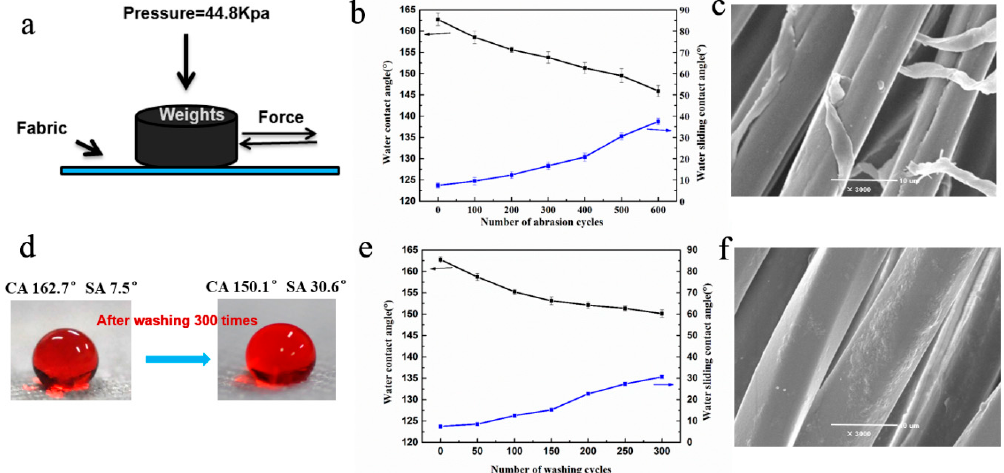
Figure 4. Abrasion and washing tests. ( a – c ) Abrasion tests: ( a ) Schematic diagram of abrasion test, ( b ) Variation of water contact angle and sliding angle with the numbers of abrasion tests, ( c ) SEM images of the PDMS@ZnO fiber after 600 cycles of abrasion; ( d – f ) Washing tests: ( d ) Photos of water drops on the PET-PDMS@ZnO fabric after 300 cycles of washing, ( e ) Variation of water contact angle and sliding angle with the numbers of washing tests, ( c ) SEM images of the PDMS@ZnO fiber after 300 cycles of